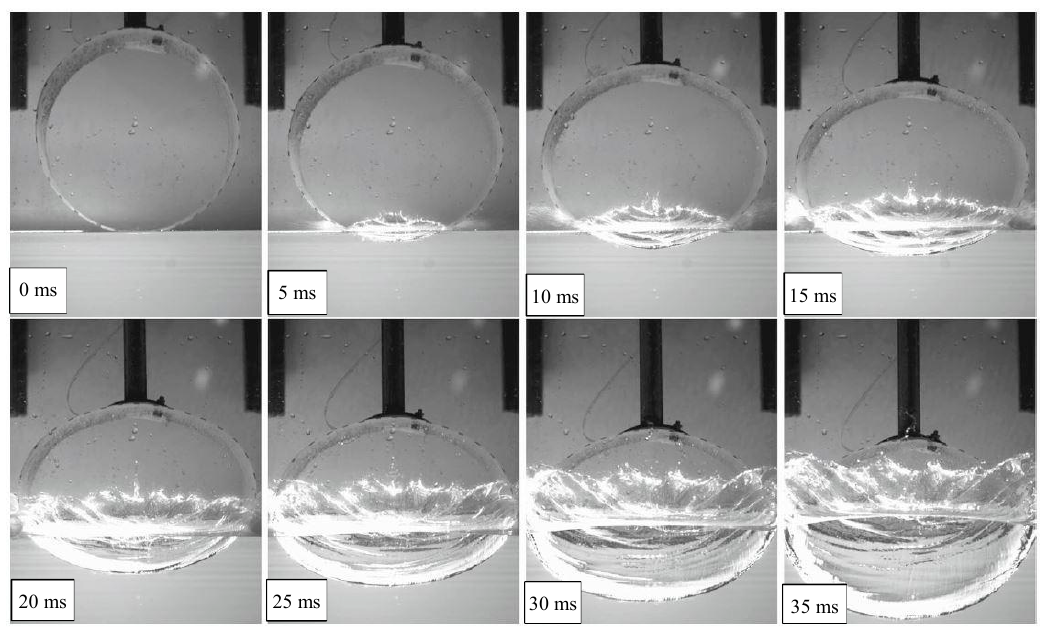
Figure 7. High speed images of a cylinder falling from a drop height of 1500 mm after the impact [42] .